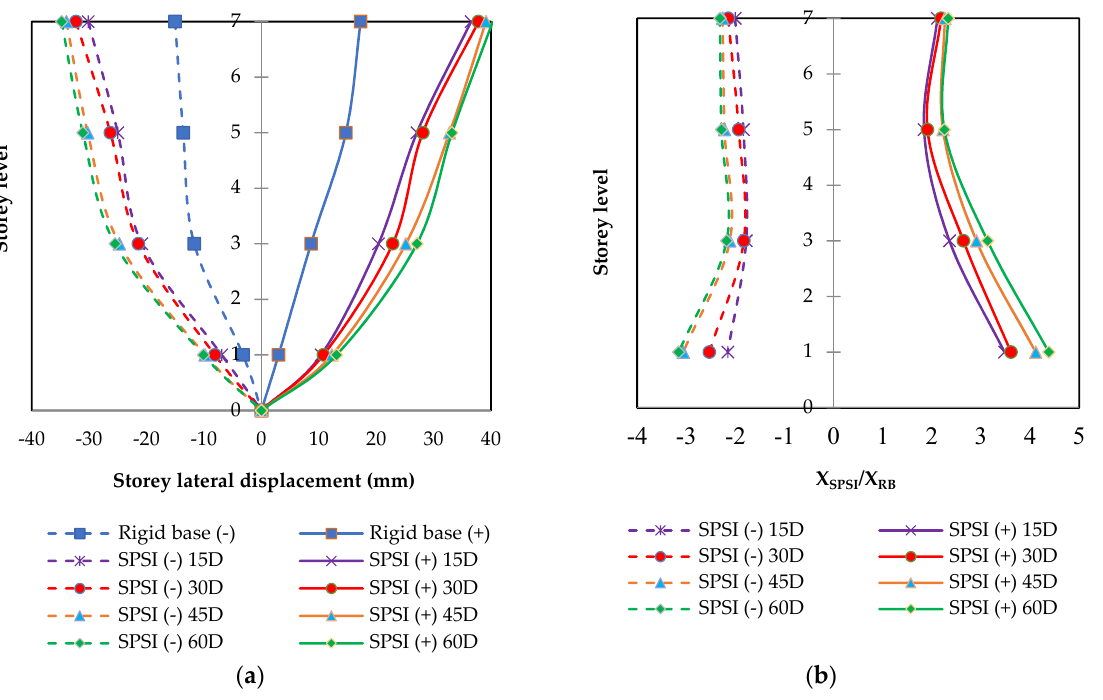
Figure 15. Effect of the L/D ratio on: ( a ) story lateral displacement, and ( b ) the X SPSI /X RB of the soil-pile-supported structural models, compared to the rigid-base structural model.